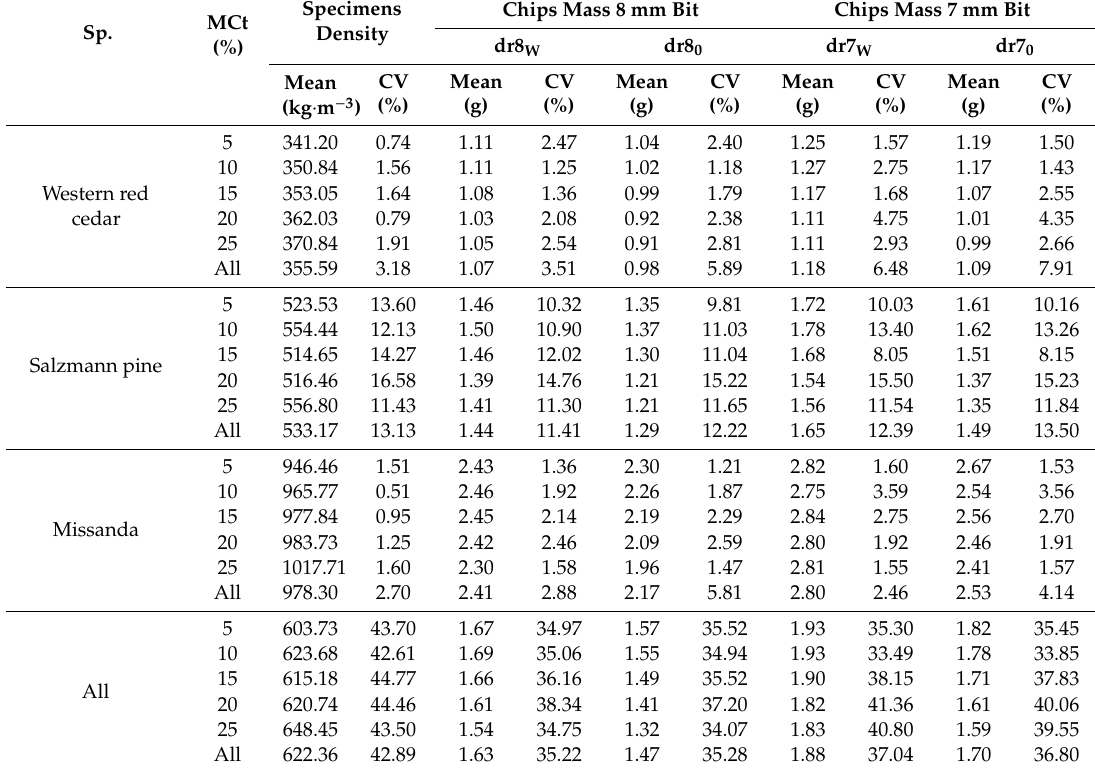
Table 4. Average values and coe ffi cients of variation of specimens’ density and chips mass by species.